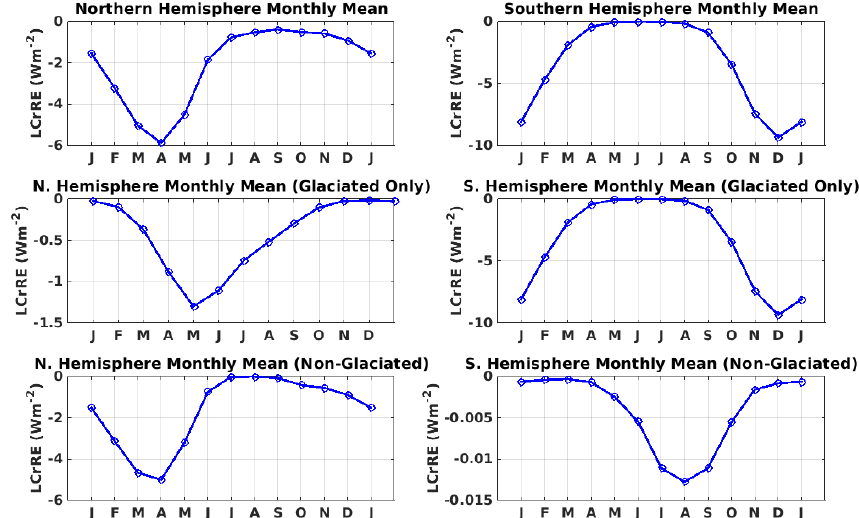
Figure 5. All-sky LCrRE averaged over the Northern (left panels) and Southern (right panels) Hemisphere, shown as contributions from all land within the hemisphere (top panels), permanently glaciated areas only (middle panels) and non-glaciated areas only (bottom panels). Data were derived with the CAM4 radiative